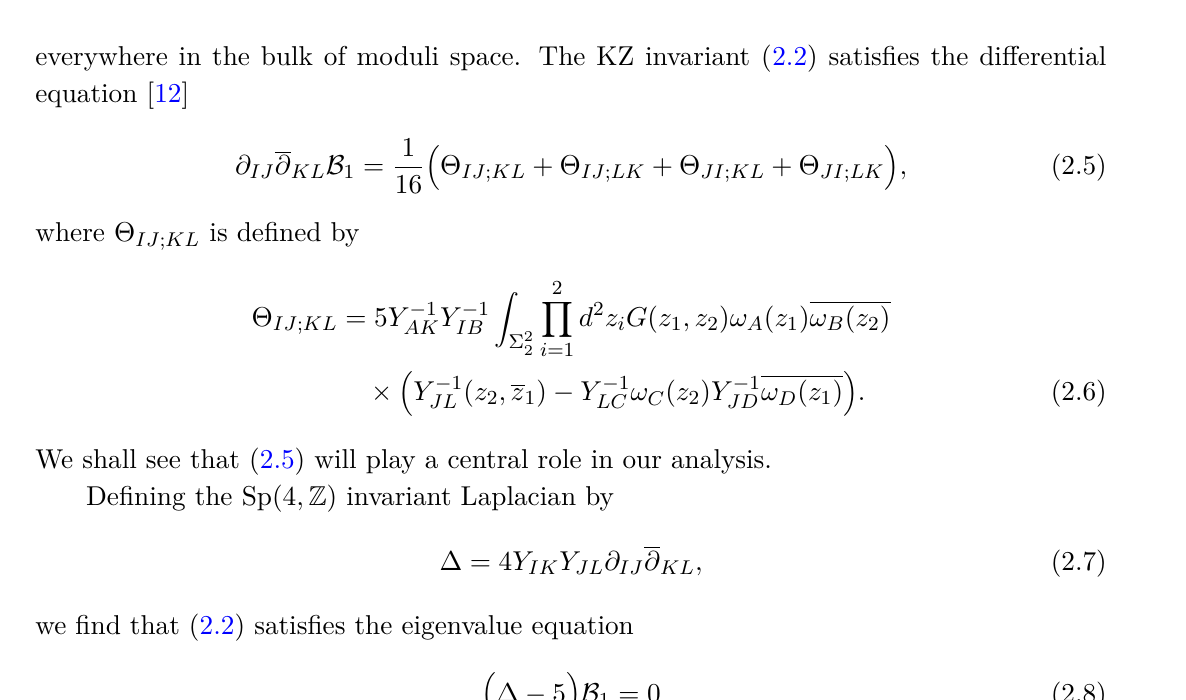
Figure 1 . The string invariant B 1